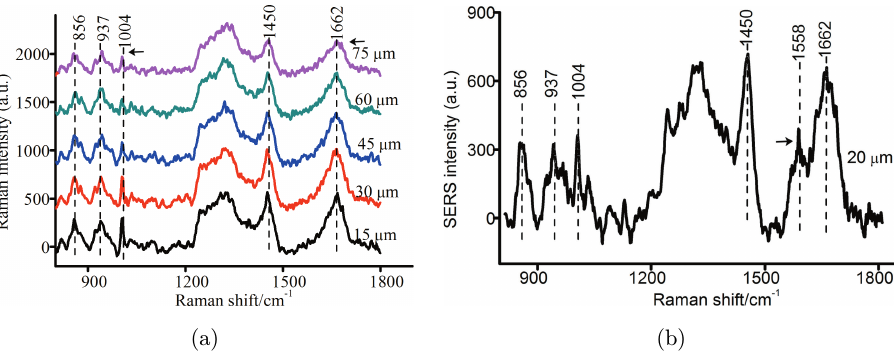
Fig. 4. (a) Normal Raman spectra of rat skin and (b) SERS spectra of the skin after topical application of GNPs. The SERS spectra of the skin re°ected the information on skin and GNAs formed in skin tissues. After topical application of GNPs, as a consequence of their exposure to the changing tissue environment, individual GNPs form nanoaggregates. The peaks at 1004 and 1662 cm (cid:1) 1 were selected as the skin marker. The peak at 1588 cm (cid:1) 1 from the citrate group was used as GNAs marker (arrows indicated in Fig.